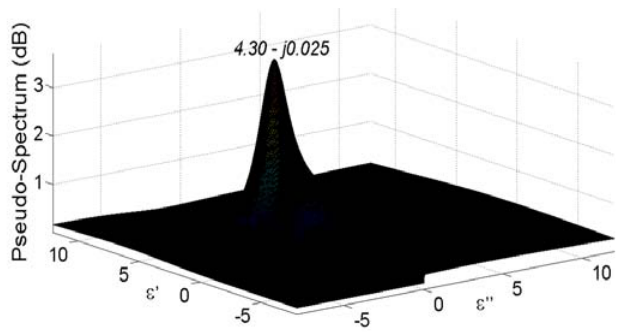
Figure 6: Pseudo-spectrum of FR-4 sample at 801 frequencies, frequency range 4.0 GHz and thickness 70 mm.